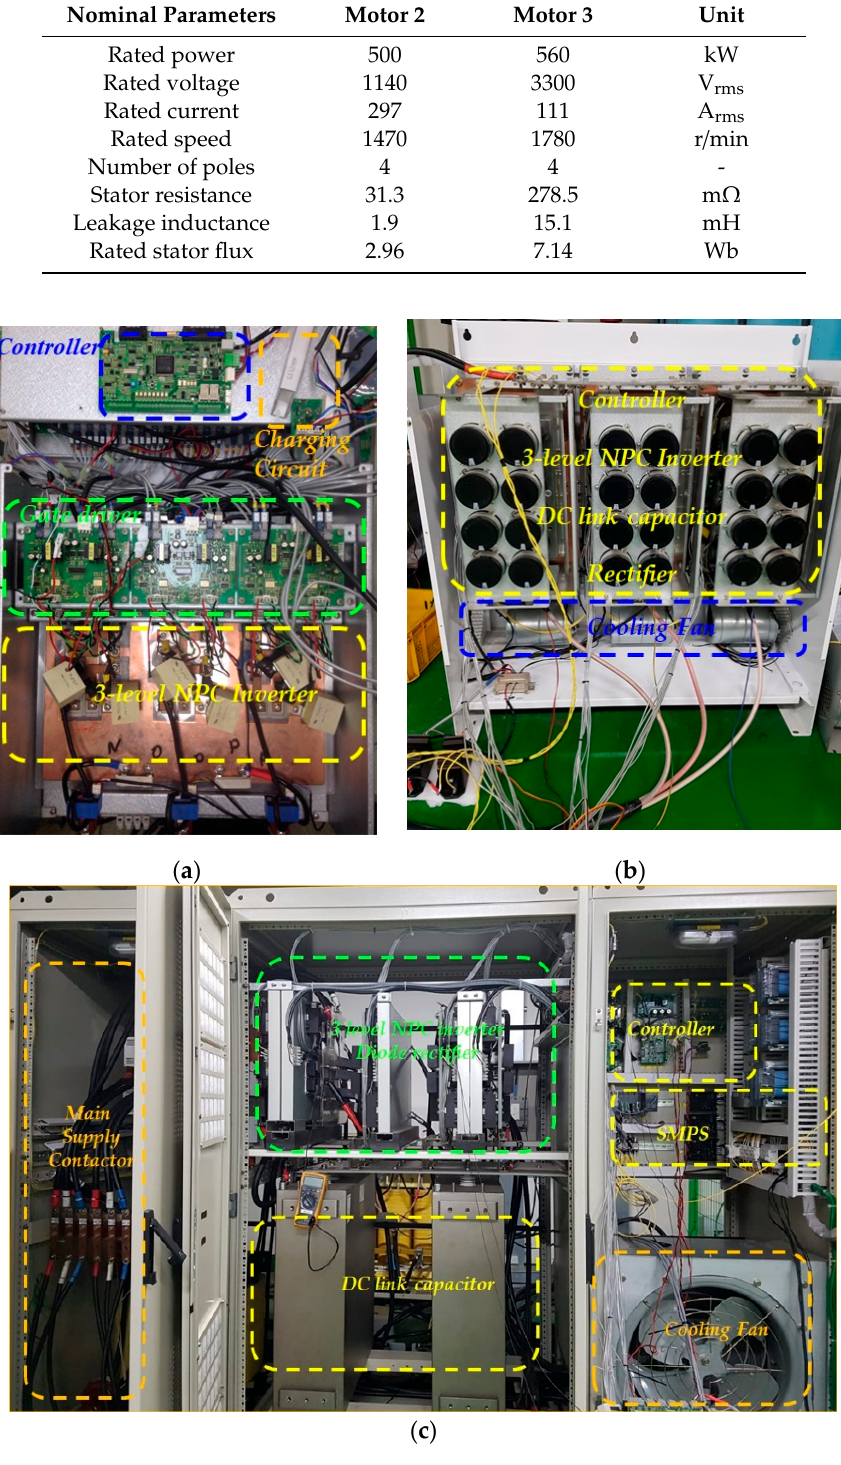
Figure 10. Experiment setup for three-level neutral point clamped (NPC) inverters: ( a ) Inverter 1, ( b ) Inverter 2, ( c ) Inverter 3.